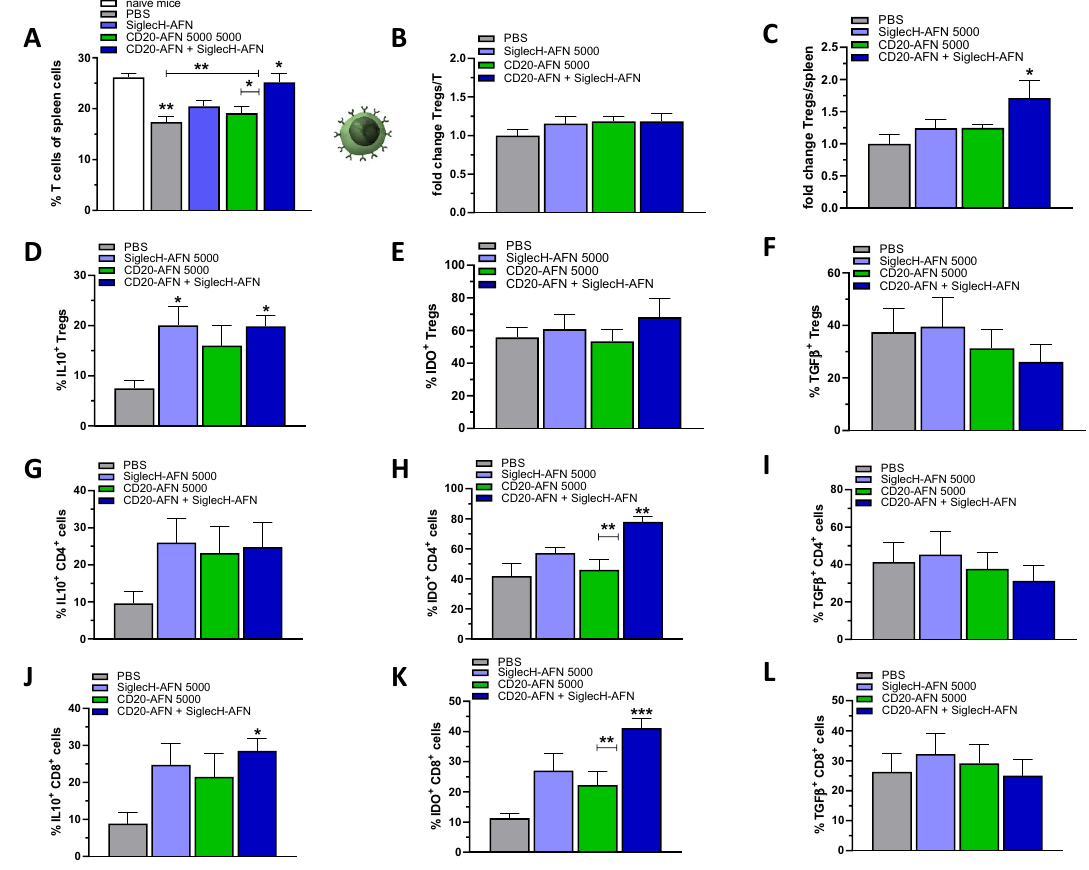
Figure 5. Superior protective combination therapy correlates with IL-10 and IDO expression in T cells. Amounts of splenic T cells were decreased on d15 due to EAE, monotherapy AFNs did not affect that but the combination therapy did ( A ). The relative amounts of Tregs on all T cells were not changed ( B ), but in the whole spleen cell population significantly more Tregs were present in case of combination therapy ( C ). CD4 + CD25 + FoxP3 + Tregs produced more IL-10 if treated with SiglecH-AFN ( D ), but IDO and TGFβ expression were not affected ( E , F ). In all CD4 + T cells ( G – I ) IL-10 expression tended to be increased by all therapies, IDO expression was significantly enhanced only if EAE mice were treated with the combination therapy, while TGFβ levels were not altered. In CD8 + T cells ( J – L ) IL-10 and IDO expression were increased in case of combination therapy, TGFβ levels were not altered. Shown are 2 pooled experiments (n = 7). Differences were assessed using one-way ANOVA followed by Tukey’s multiple-comparison test; *P < 0.05, **P < 0.01, ***P < 0.001, compared with PBS treated animals, unless otherwise